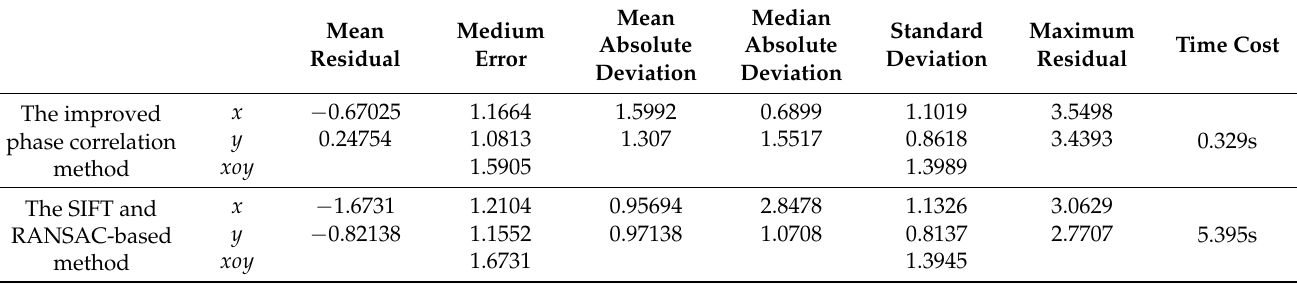
Figure 8. Image registration results using the improved phase correlation method: ( a ) Urban scape; ( b ) River course. Table 4. The image registration accuracy—urban scape (units in meters).